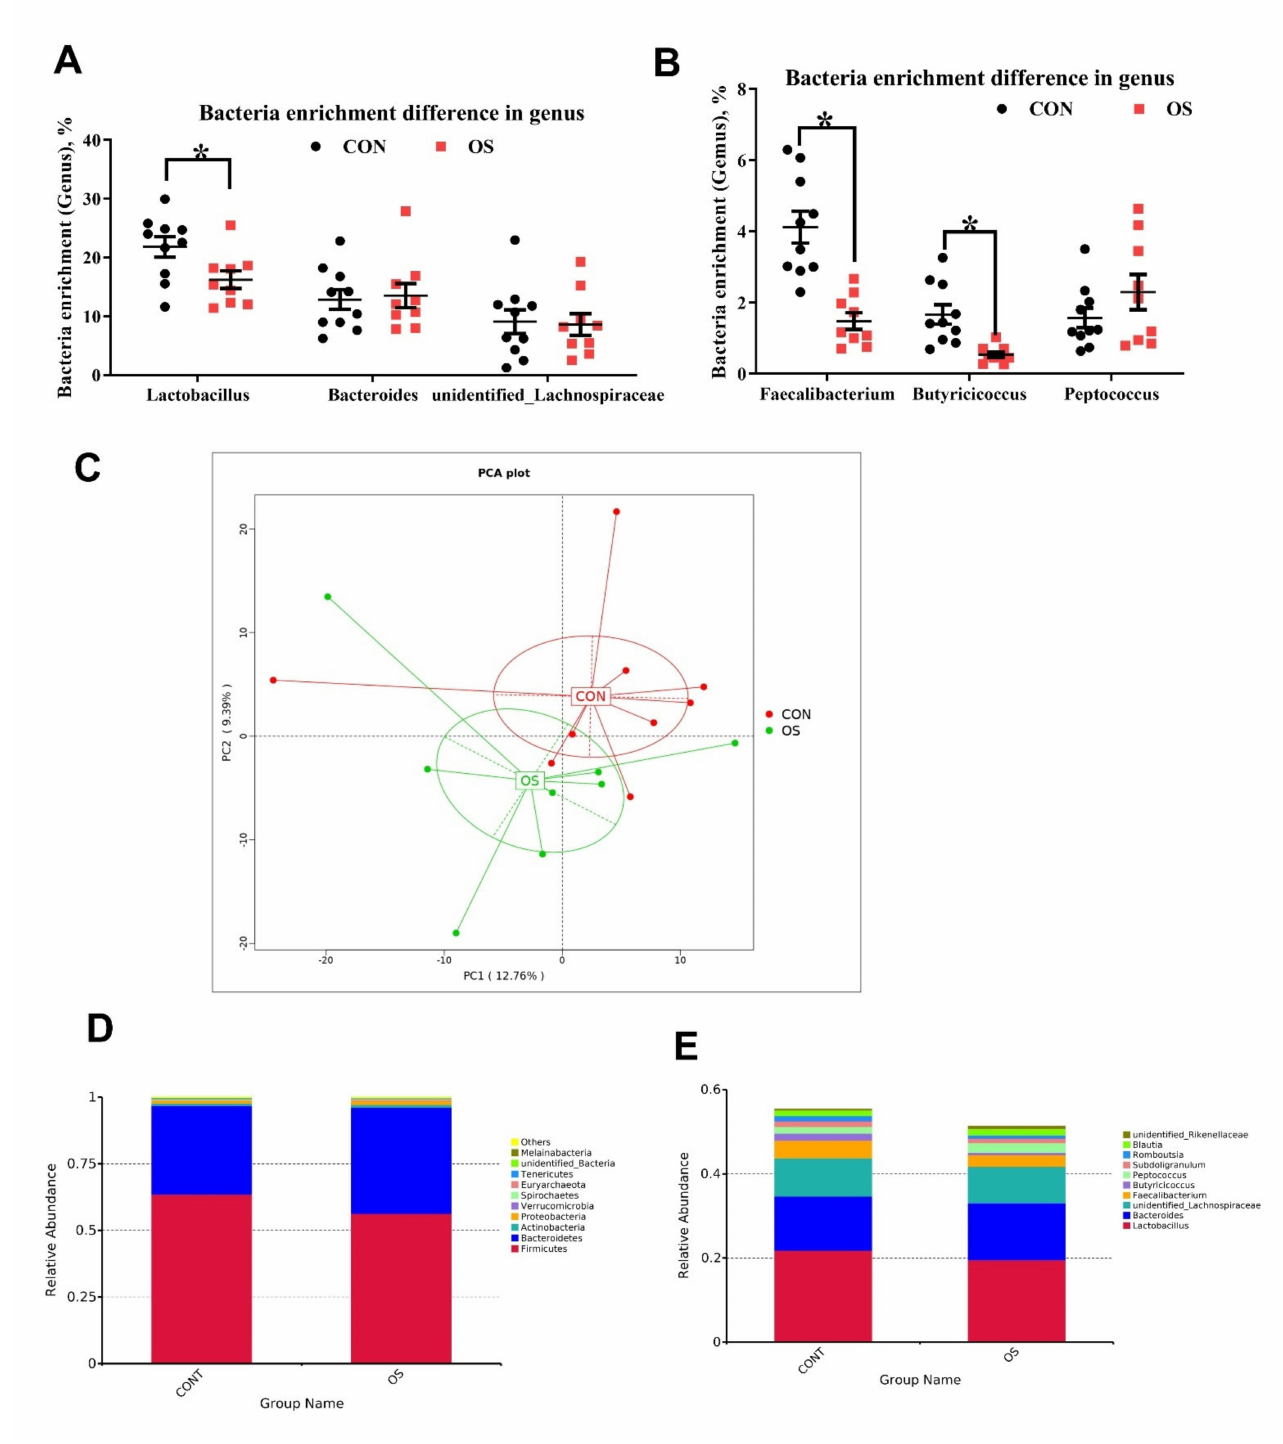
Figure 5. Oxidative stress (induced by tBHP) changed microbiota diversity (Experiment 1). Data are means ± SEM represented by vertical bars or plot individual values. ( A , B ) The bacteria abundance enrichment difference in the genus. ( C ) The principal coordinate analysis (PCoA) of the cecum microbiota based on unweighted UniFrac metrc. ( D , E ) The relative abundance of the top 10 phylum ( D ) and genus ( E ). The difference n = 10. Statistical significance was evaluated by the Student’s t -test, * p <